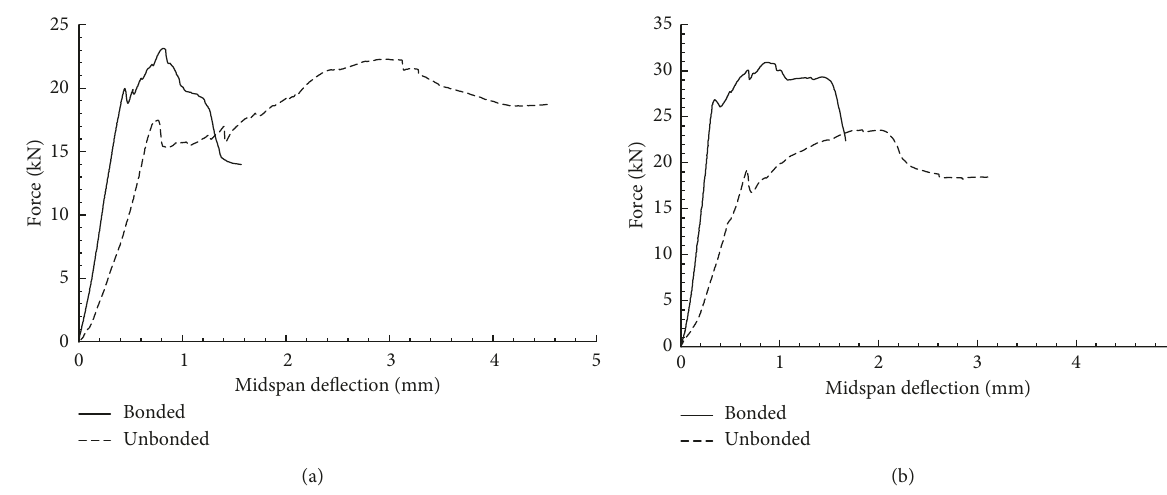
Figure 6: Effect of bonding conditions on composite beam behavior. (a) Without fiber mesh. (b) With fiber mesh.